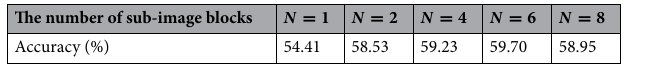
Table 1. Accuracy of the proposed method.